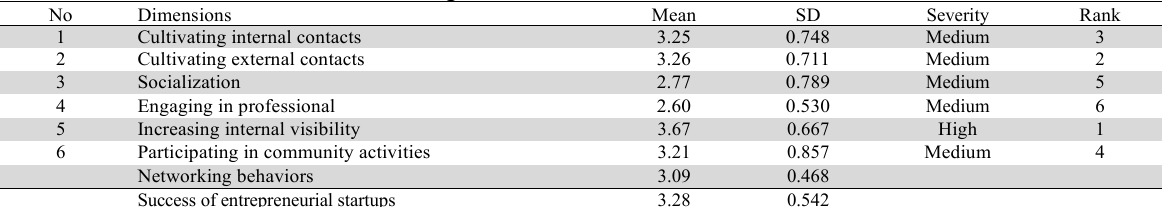
Means and Standard Deviations of Networking Behaviors Dimensions No